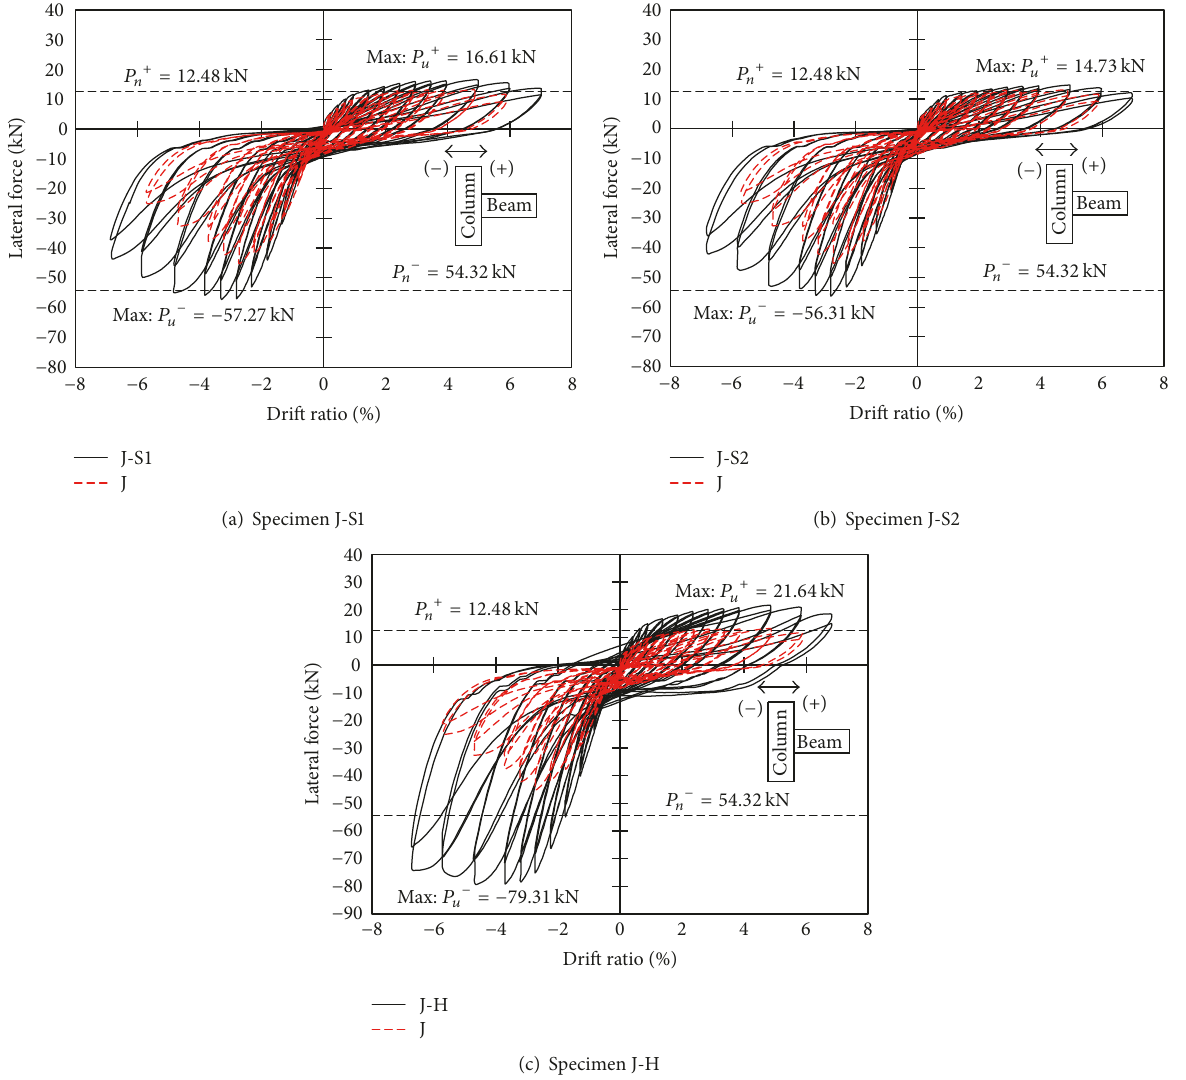
Figure 8: Lateral load-drift ratio relationships of test